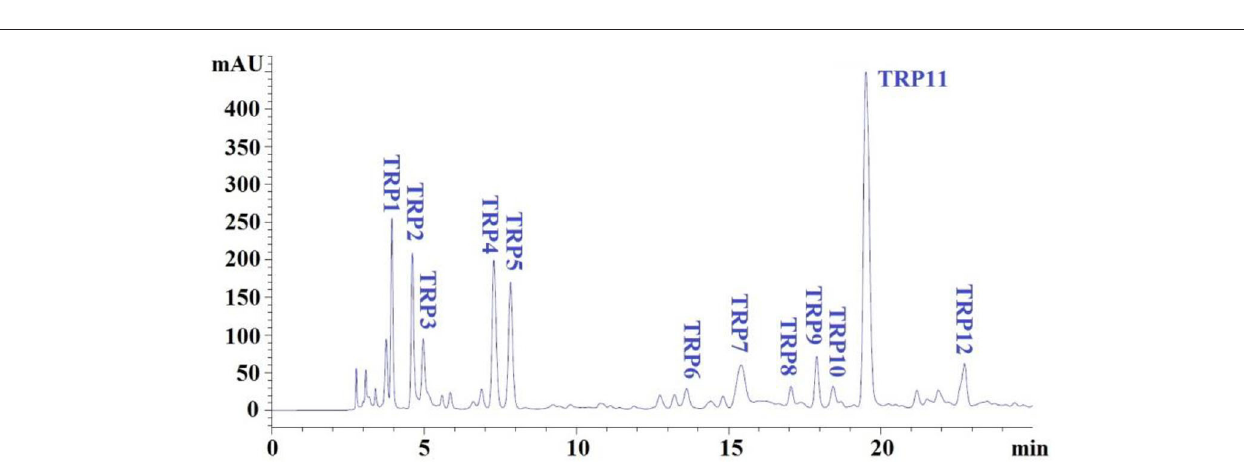
ESI/MS, and the data are displayed in Table 2 . The sequences of TRP1 to TRP12 were identified as Ser-Gly-Glu